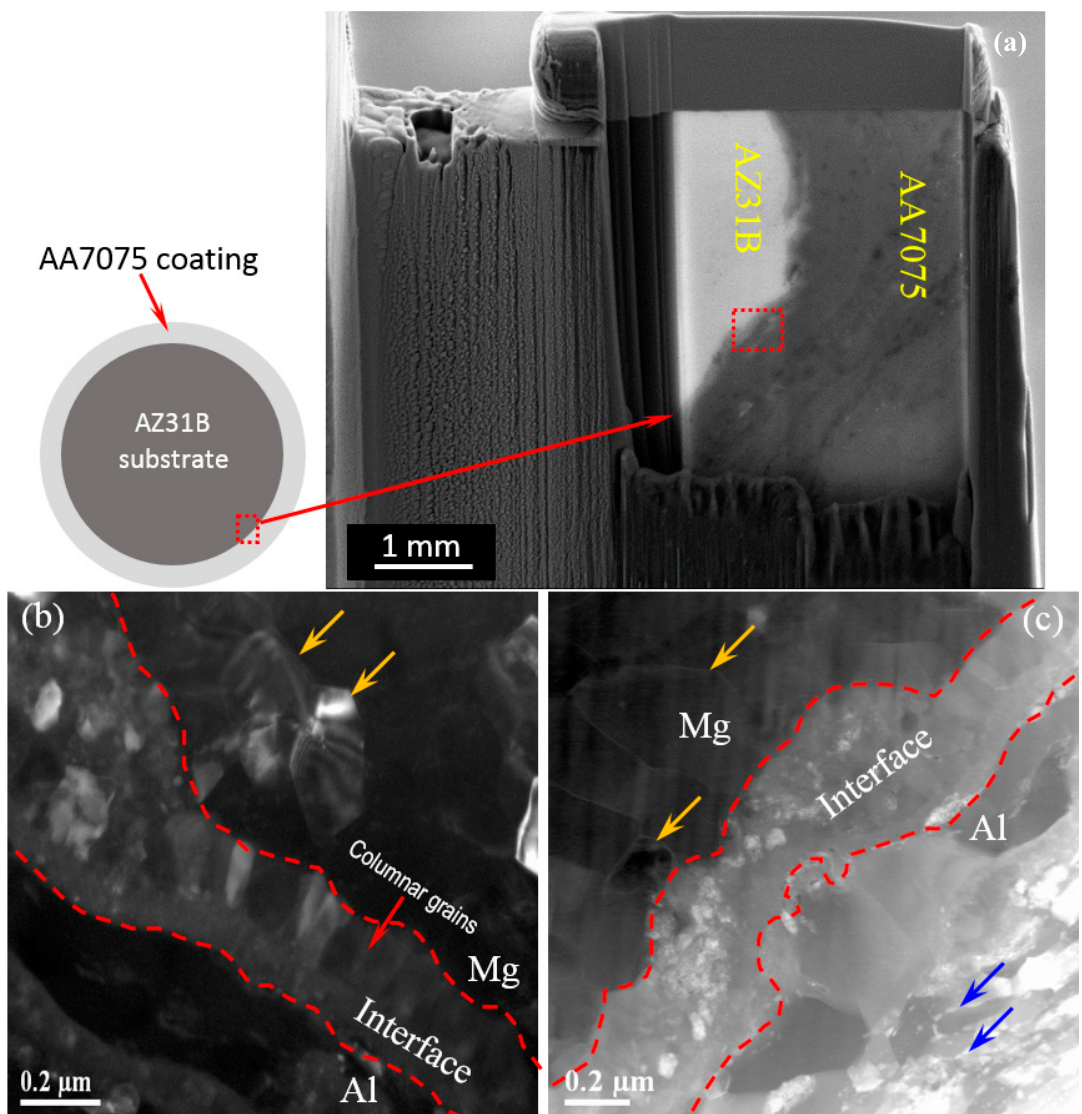
Figure 1. A schematic cross-sectional view of the coated sample along with ( a ) the TEM membrane, prepared by focus ion beam (FIB) milling; ( b ) the dark-field DF image; and ( c ) the high-angle annular dark-field (DF) scanning transmission electron microscopy (HAADF-STEM) image of the Al7075 cold spray coating on the AZ31B substrate. The dotted line shows the boundary of the interface between